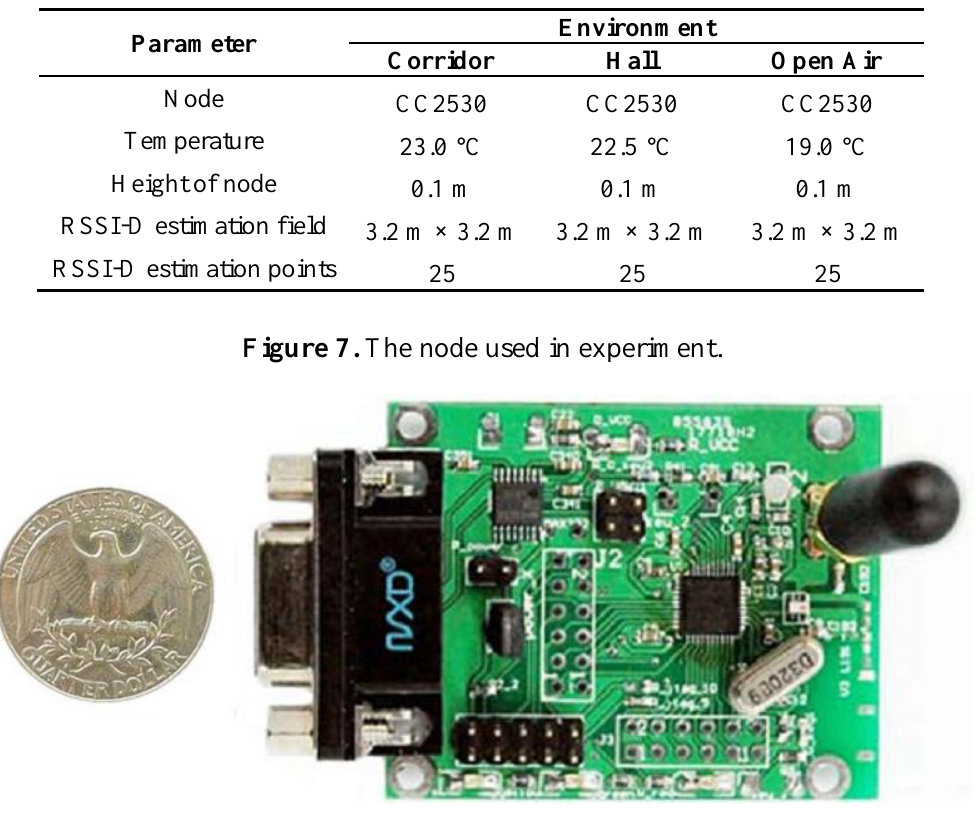
Table 1. Experiment conditions and parameters .